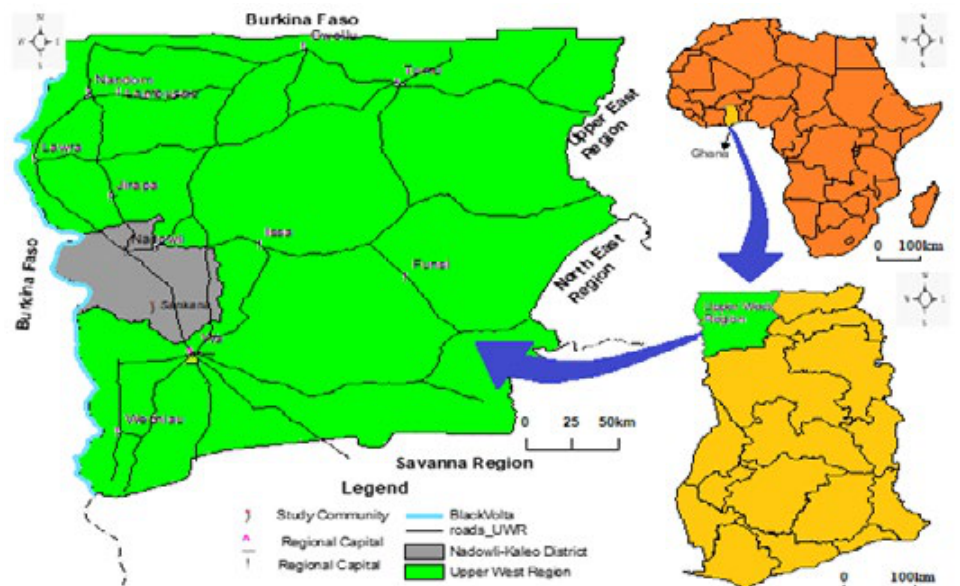
Fig. 1 : Geographic location of Sankana in the Upper West Region of Ghana Fig. 1: Geographic location of Sankana in the Upper West Region of